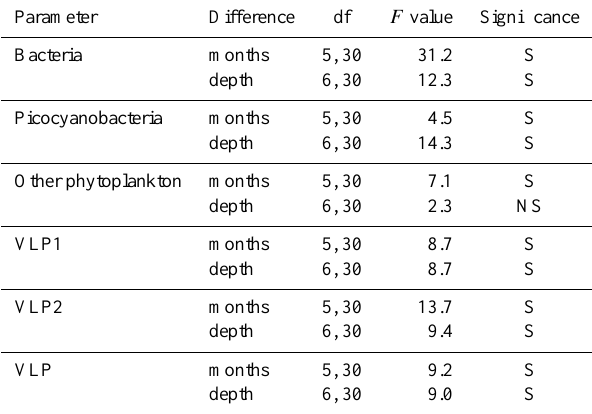
Table 4. Results of the two-way ANOVA to test significant differ- ences in the abundance of bacteria, picocyanobacteria, other phy- toplankton and VLPs. Degrees of freedom are indicated as